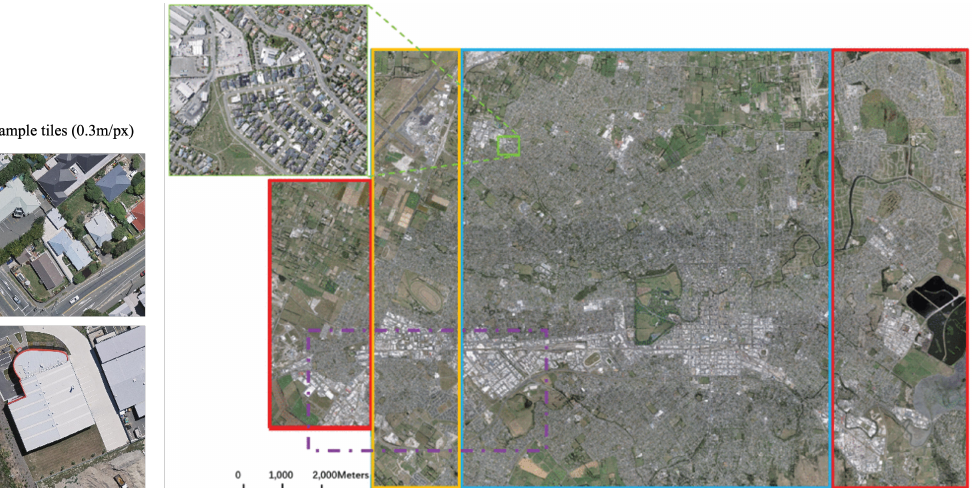
Figure 1. Aerial imagery of the WHU Building dataset set in Christchurch, New Zealand, and sample training images of 0.3 m spatial resolution with low-rise building structures (adopted from